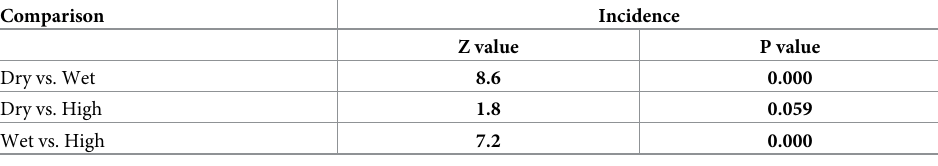
Table 4. Comparison of the number of leptospirosis cases among meteorological zones of Sri Lanka (Mann-Whit- ney U -test). Comparison